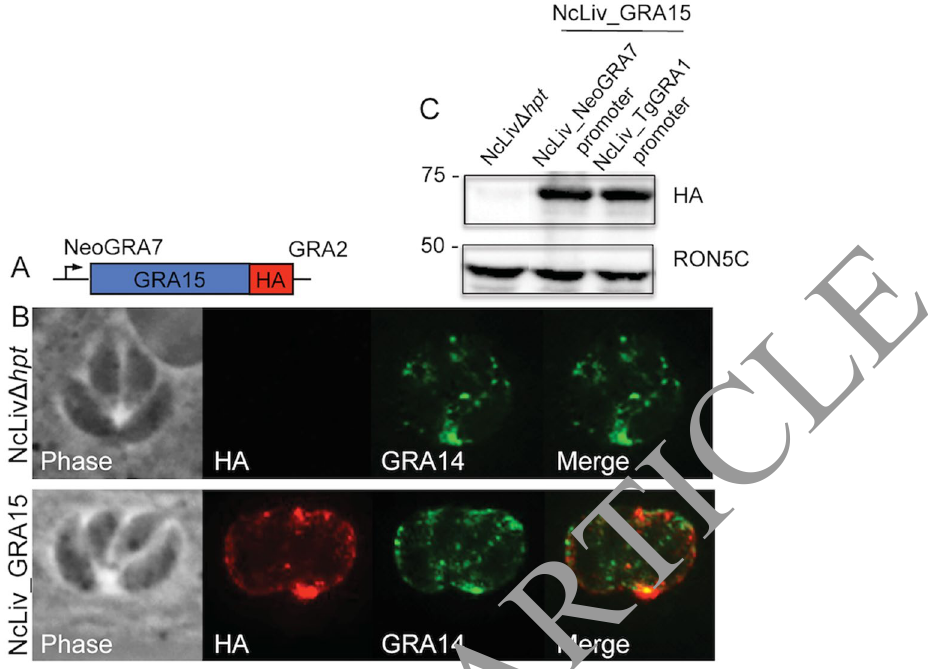
Figure 3. Expression of type II T. gondii GRA15 gene in N. caninum . ( A ) Diagram of the expression cassette encoding TgGRA15 plus C-terminal 3xHA epitope tag, driven by the N. caninum GRA7 promoter, ( B ) expression of GRA15-expressing N. caninum tachyzoites confirmed by IFA. GRA15 was localized in the parasitophorous vacuole by its HA tag, where it colocalized with the GRA14 marker. Red, rabbit anti-HA antibody; green, mouse anti-GRA14 antibody. Microscope magnification: 63x, ( C ) Expression of TgGRA15 in transgenic N. caninum tachyzoites confirmed by Western blot. TgGRA15 was detected by its HA tag present in the constructs driven by N. caninum GRA7 promoter. Full-length blots are available in Supplementary dataset